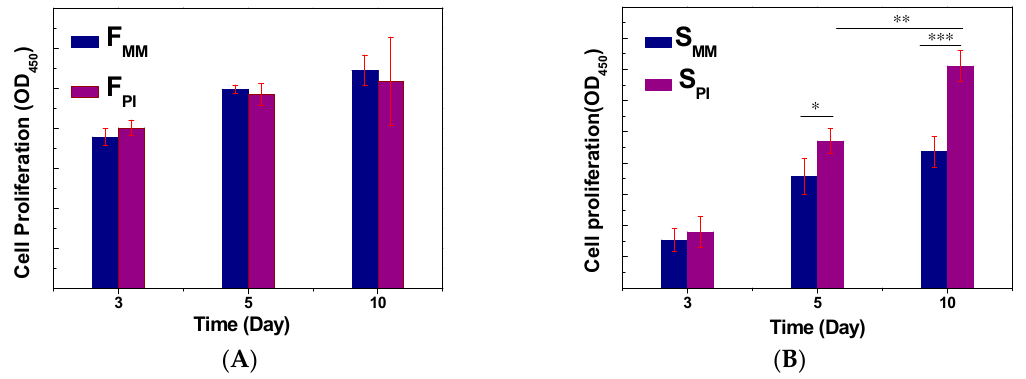
Figure 6. Cell proliferation on different films ( A ) and scaffolds ( B ) for three, five, and 10 days. Data are presented as mean ± SD ( n = 6, * p < 0.05; ** p < 0.01; *** p < 0.001).